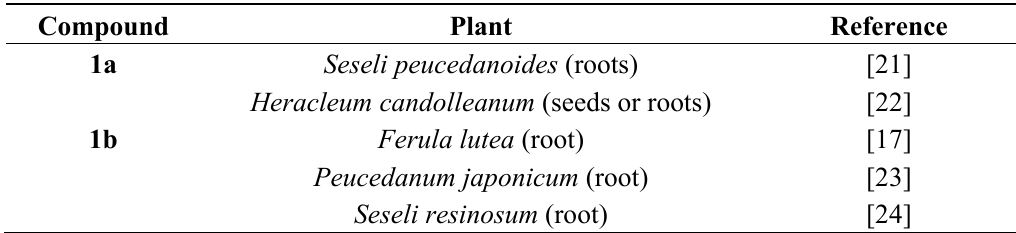
Table 3. Various plants and organs containing compounds 1a and 1b